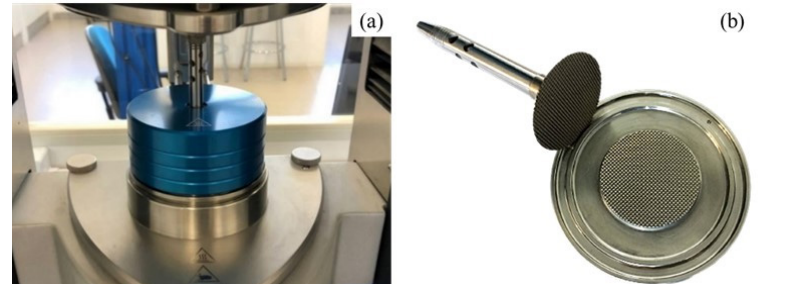
Figure 3. Rheological tests setup used. (a) Rheological tests setup with insulation chamber used to prevent the mixing water evaporation; (b) parallel-plate geometry with hatched surface.